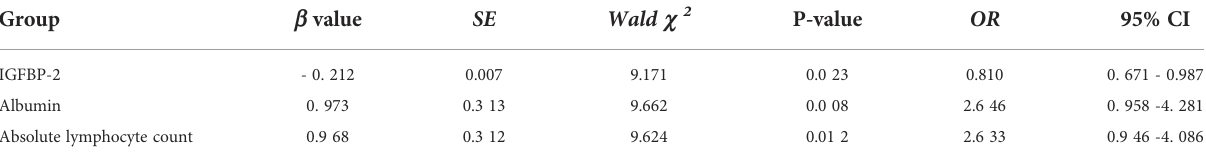
TABLE 4 Relationship analysis between serum IGFBP-2, albumin, absolute lymphocyte levels and PNI.